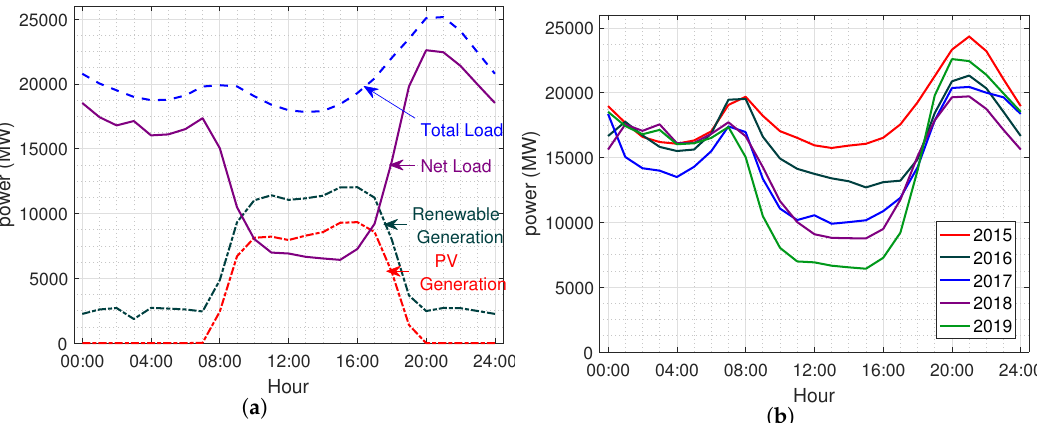
Figure 4. Load profile of California ISO; ( a ) Load demand and generation on 31 March 2019, and ( b ) net load profile on March 31 for last 5 years (2015-19) [33].